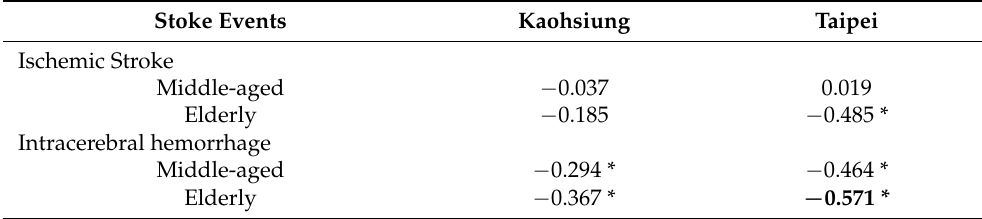
Table 2. Spearman’s rank correlation coefficients between monthly mean temperatures and stroke events.